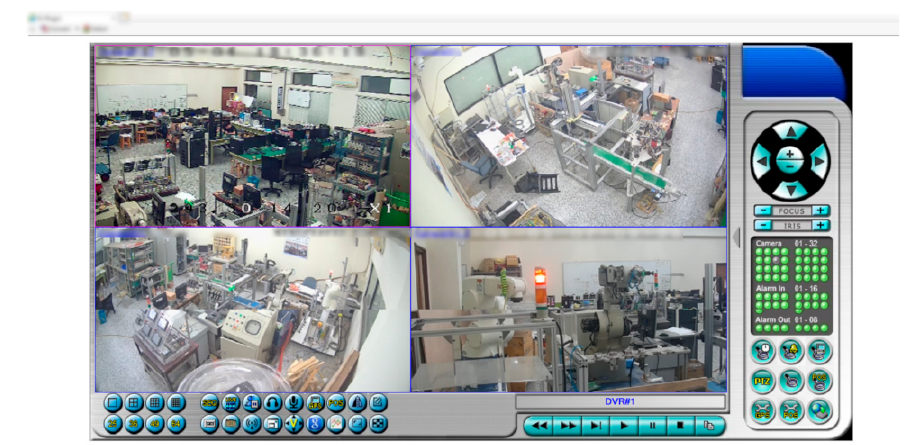
Figure 20. Remote monitoring